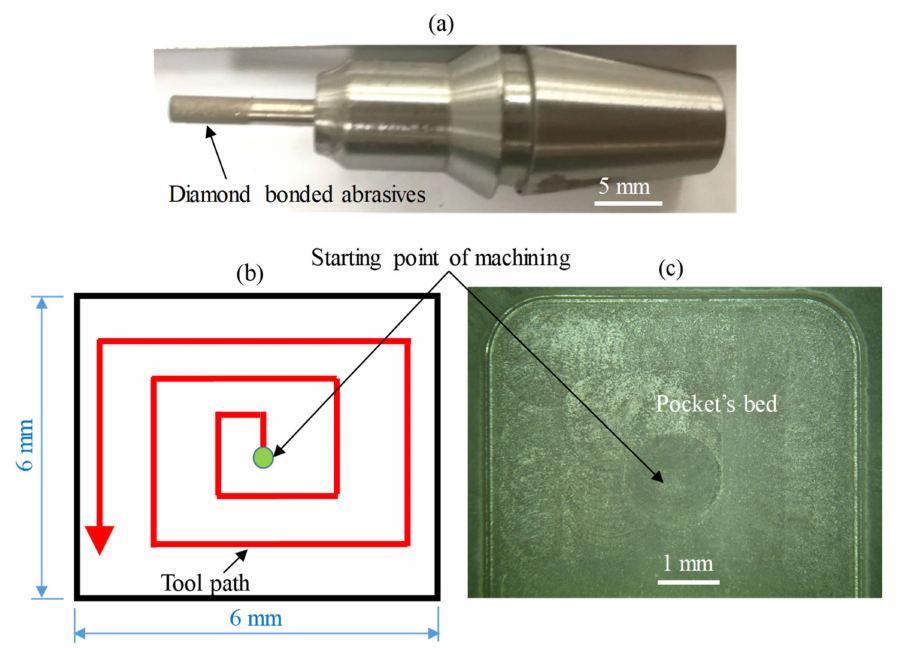
Figure 2. ( a ) RUM used tool, ( b ) schematic of the tool path of the machined pocket, ( c ) a sample of an actual machined